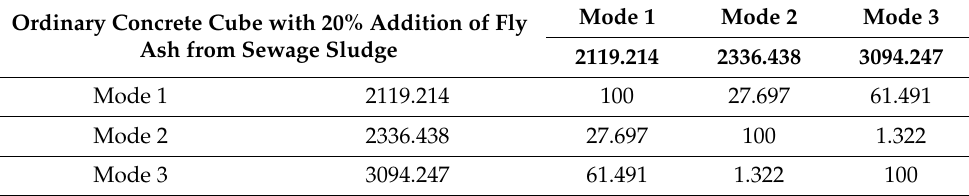
Table 5. Pre-determined natural frequencies of the ordinary concrete cube with the 20% addition of fly ash from sewage sludge ash.